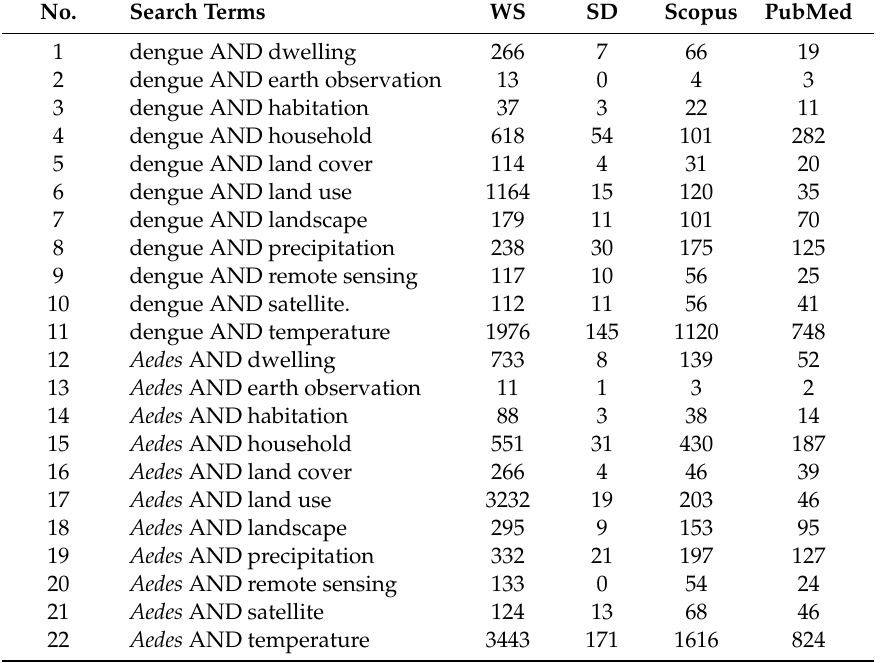
Table A1. Search terms and number of records derived from bibliographic